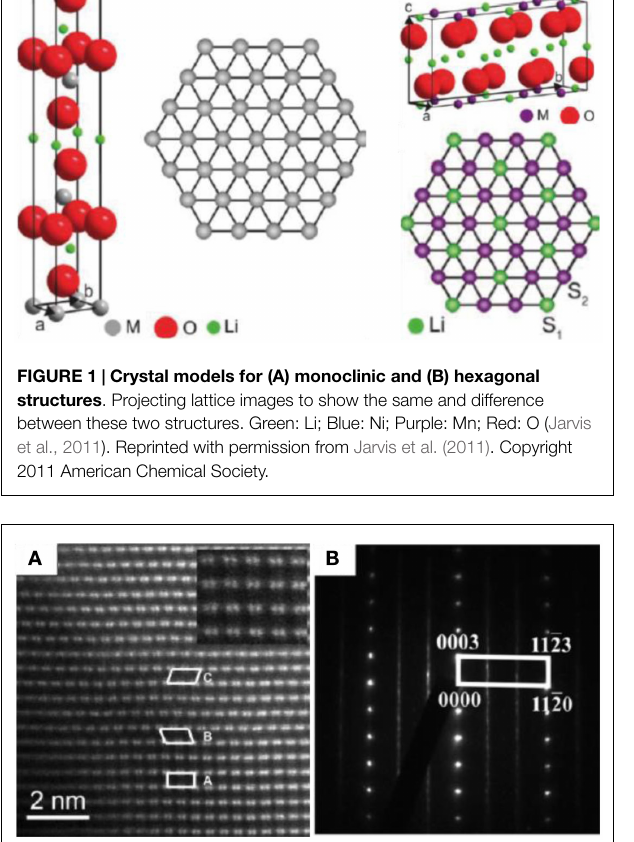
FIGURE 2 | (A) [100] m zone axis STEM-HAADF image of pristine 20N-LMR cathode. Areas marked A, B, and C in (A) correspond to the [100] zone axis, the [1–10] zone axis, and the [110] zone axis, respectively (Jarvis et al., 2011). (B) SAED pattern of pristine 20N-LMR cathode recorded along an [010] zone axis. Continuous narrow streaks along (0001) indicate the presence of several locally monoclinic domains (Bareno et al., 2010). Reprinted with permission from Jarvis et al. (2011) and Bareno et al. (2010). Copyright 2011 American Chemical Society and 2010 John Wiley & Sons,